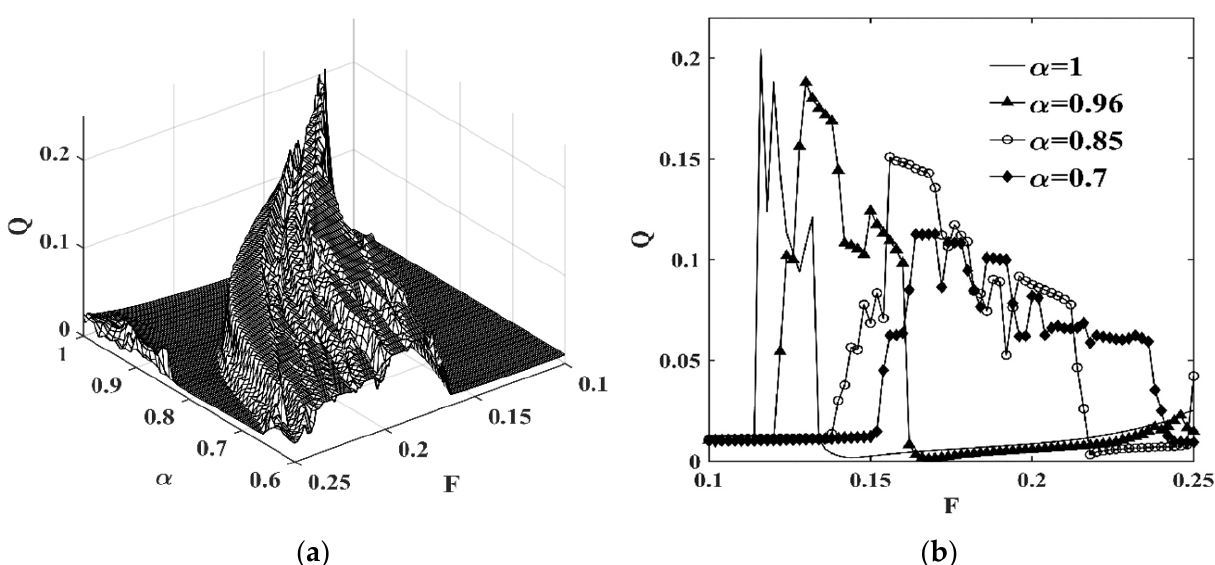
α F Figure 1. Response amplitude Q as a function of α and F . ( a ) The three-dimensional surface of Figure 1. Response amplitude Q as a function of and . ( a ) The three-dimensional surface response amplitude Q versus α and F ; ( b ) response amplitude Q versus F for different values of α α F and ; ( b ) response amplitude Q versus of response amplitude Q versus α . ent values of